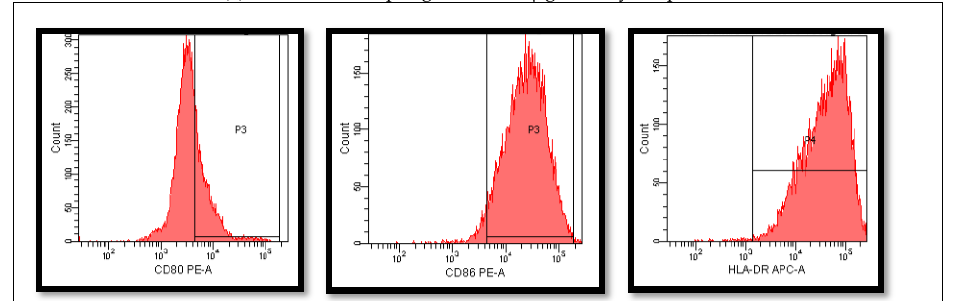
Figure 5. Flow cytometry histograms for the different detected cell-surface molecules on macrophages before and after treatment with TQ. A representation of flow data histograms for the cells’ gating setting and expression detection is shown. ( a ) Gate setting for the different fluorescent dyes used in the experiment (FITC, PE, APC). ( b ) Macrophages differentiated after 7 days’ culturing in the presence of GM-CSF. ( c ) Macrophages differentiated after 7 days’ culturing in the presence of GM-CSF and treated with 50 µ g/mL TQ 24 h. ( d ) Macrophages differentiated after 7 days’ culturing in the presence of GM-CSF and treated with 50 µ g/mL TQ 24 h. TQ, thymoquinone; FITC, fluorescein isothiocyanate ; PE, phycoerythrin; APC-A, allophycocyanin; CD80 PE-A, phycoerythrin monoclonal anti cluster of differentiation 80; CD86 PE-A, phycoerythrin monoclonal anti cluster of differentiation 86; HDLA-DR APC-A, allophycocyanin monoclonal anti cluster of differentiation human leukocyte antigens